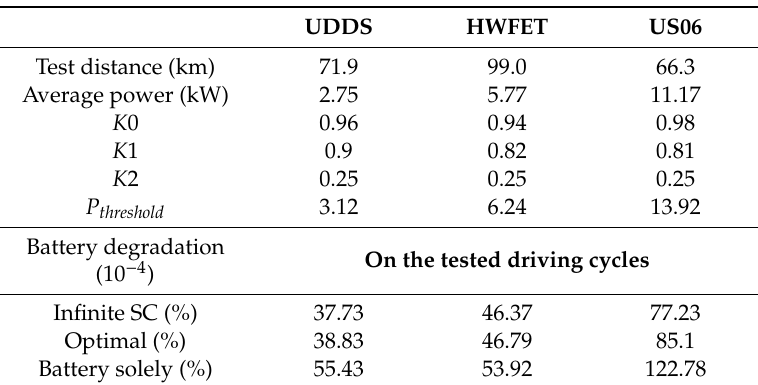
Table 3. Searching results for parameters.